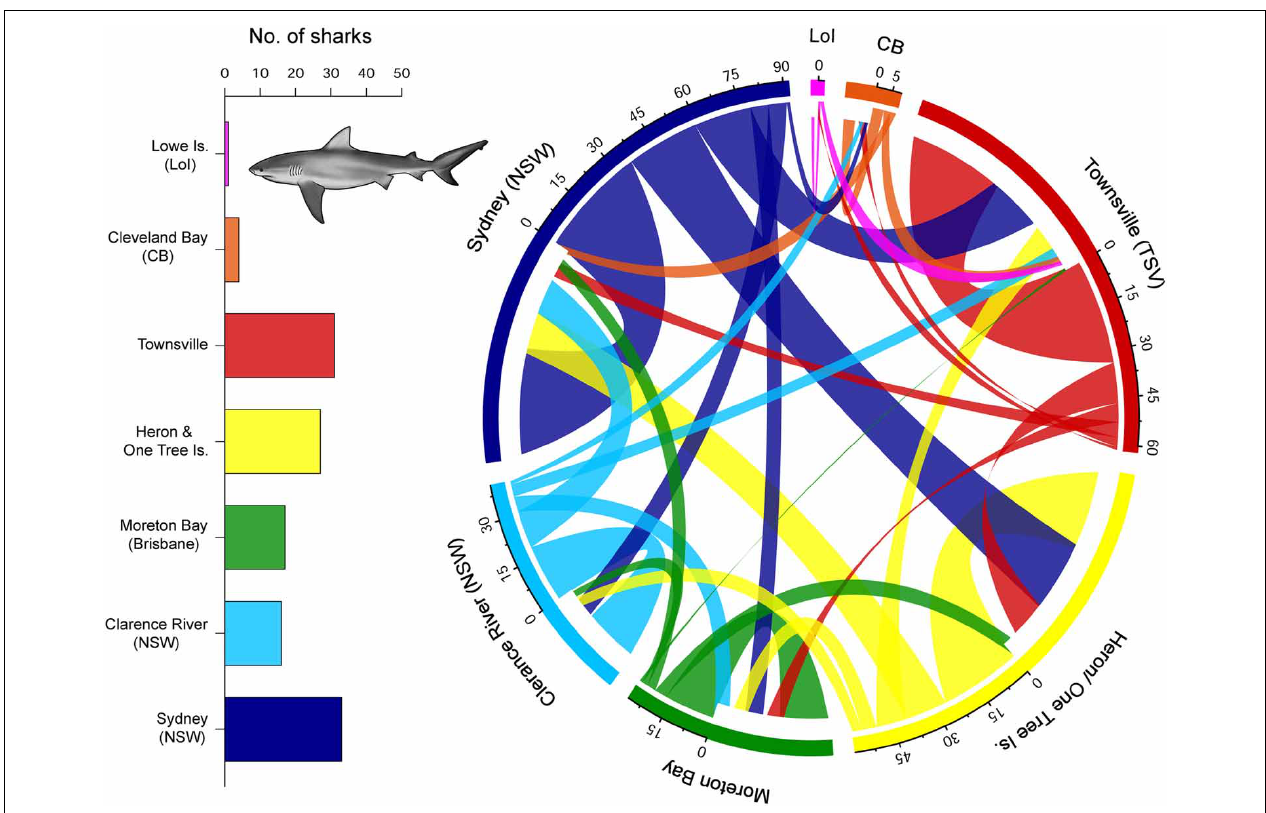
FIGURE 3 | Connectivity plot indicating moves of individual C. leucas between acoustic receiver arrays. Line thickness represents density of movements. The number of sharks detected by location are indicated on the inset bar